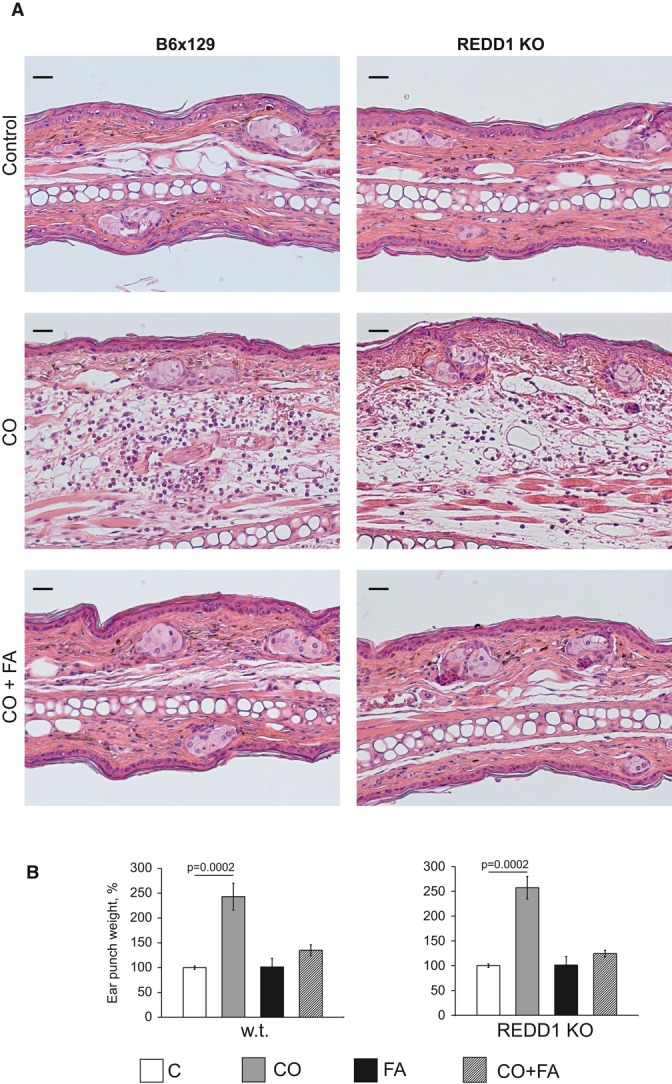
Similar sensitivity of REDD1 KO and wild-type animals to the anti-inflammatory effect of glucocorticoidsEar edema was induced by croton oil (CO) as in Materials and Methods. FA was applied 1 h before CO, and four-millimeter ear punch was weighed 9 h after CO application to assess swelling. In the additional experiment, ears were harvested 9 h after CO application and used for histological analysis.A H&E staining. Scale bars are 20 μm.B Ear punch weight. Results are presented as % to corresponding (wild-type or REDD1 KO) control ear weight. The means ± SD were calculated for six individual ear punches/condition in one representative experiment (out of three experiments). Statistical analysis for differences between treatment and corresponding control was done by the unpaired two-tailed t-test.